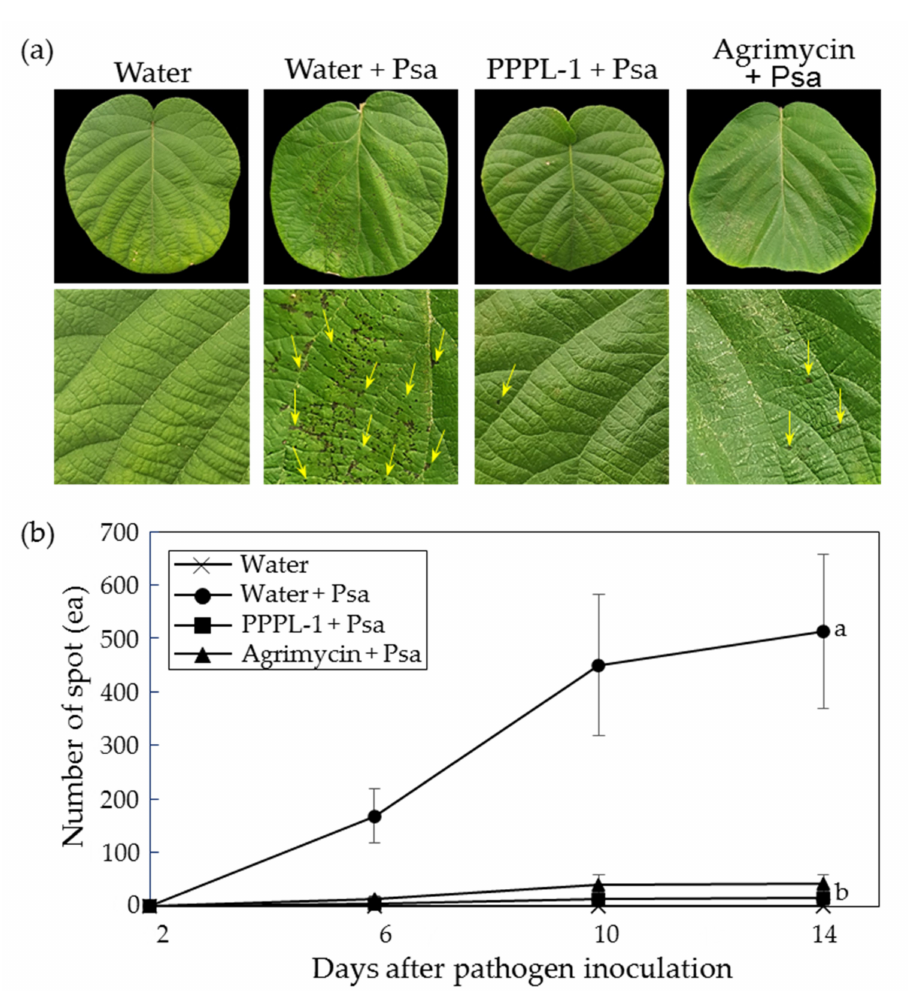
Figure 1. Control efficacy of PPPL-1 phage treatment against bacterial canker caused by Pseudomonas syringae pv. actinidiae (Psa) KBE9 and SYS1 mixture in planta. ( a ) The kiwifruit leaves 10 days after pathogen inoculation (dai) with phages or antibiotic pesticide. Bottom figures are enlarged photographs of top leaves. The yellow arrows indicate symptomatic spots. The sterilized water was used for dilution of phages and bacteria. Water, PPPL-1 (10 8 pfu/mL), or Agrimycin™ (0.4 g/L) was applied 2 h before infection with Psa (10 8 cfu/mL). ( b ) The mean of numbers of symptomatic spots on the treated leaves ( n = 12). The error bars indicate the standard error, and the different alphabets in the next of lines indicate the different groups based on significant differences at p < 0.05 by Duncan’s multiple range test at 14